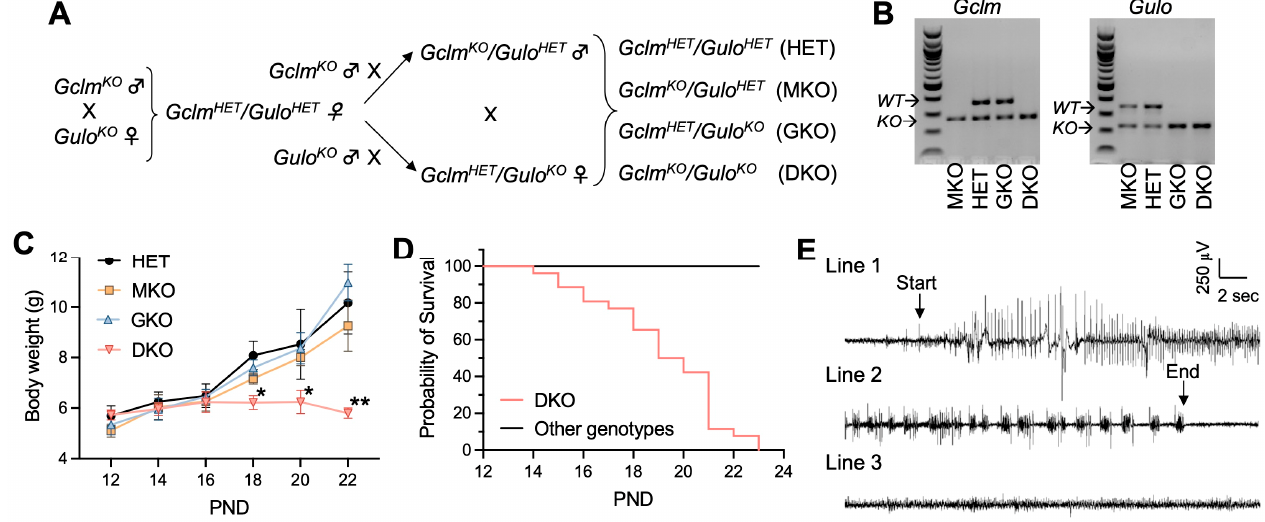
Figure 1. Genetic deficiency in GSH and AA biosynthesis leads to growth retardation, spontaneous generalized seizure and premature death. ( A ), Breeding scheme—to obtain HET, MKO, GKO and DKO lines. ( B ), Representative electrophoresis images of PCR genotyping of offspring for Gclm and Gulo alleles. PCR products derived from wild-type (WT) or knockout (KO) alleles of respective genes are labeled. ( C ), Body weight as a function of postnatal day (PND). N = 7–8/genotype. Data are expressed as means ± S.D. * p < 0.05, ** p < 0.01, when compared to age-matched HET mice by Student’s unpaired t -test. ( D ), survival rate of HET, MKO, GKO ( N = 23–25/genotype) offspring vs DKO ( N = 26) offspring. First death occurred at PND14, and last death happened on PND23. ( E ), Representative EEG of a spontaneous seizure recorded in a DKO mouse at age PND19. The EEG pattern of the onset (Line 1) and the termination of a 90-s seizure (Line 2) are compared with that of a control HET mouse (Line